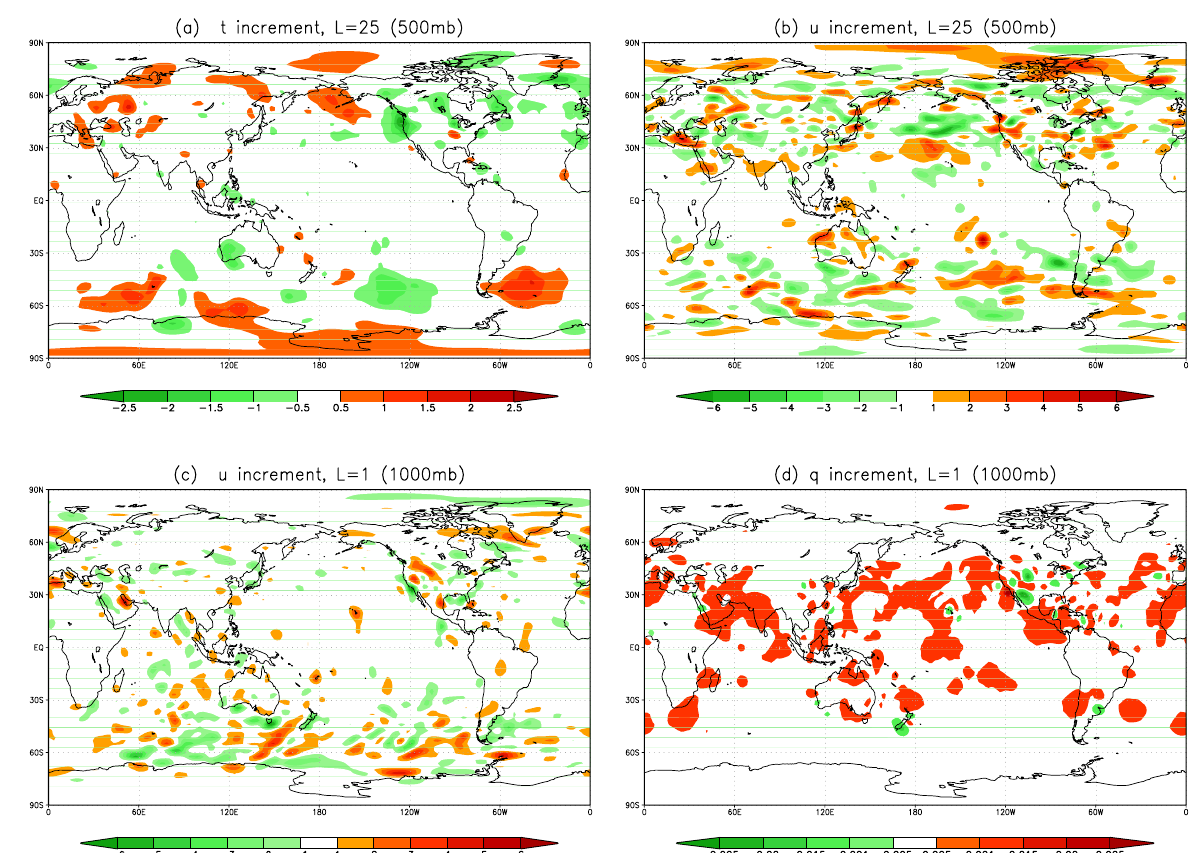
Fig. 13. The analysis increments of (a) t 500 , (b) u 500 , (c) u 1000 , and (d) q 1000